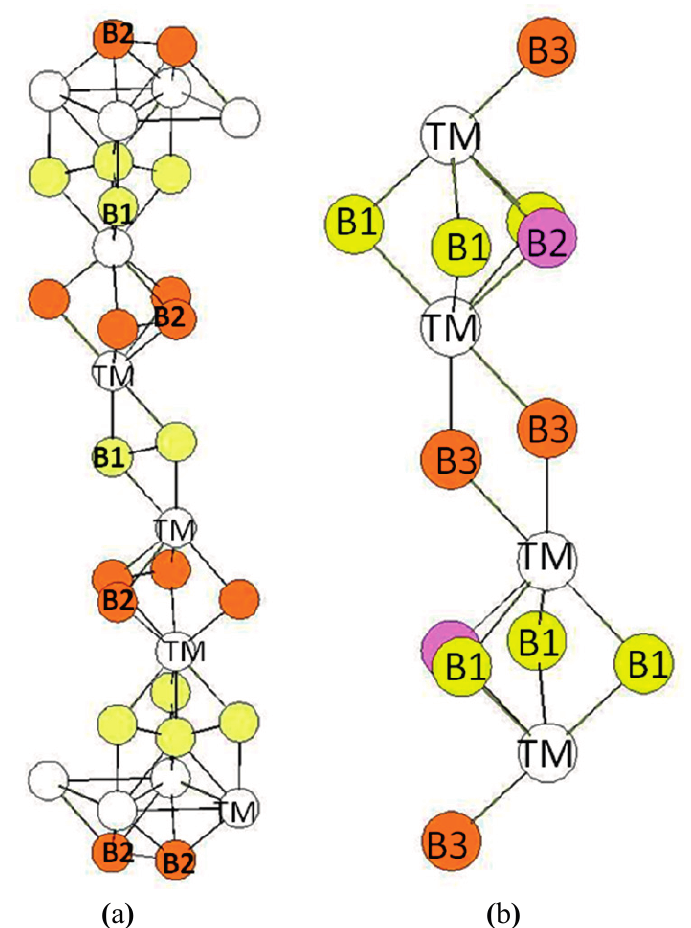
Figure 5. ( a ) hR6 (MoB 2 -type) structure. The Wyckoff positions of B1 and B2 atoms in the R(-)3m group space are 2c (x = y = z = 0.33219) and 2c (x = y = z = 0.18146); ( b ) hP12 (WB 2 -type) structure. The Wyckoff positions of B1, B2, and B3 atoms in the P6 3 /mmc group space are 2b, 2c, and 4f (see Table 1). Table 5. Bond lengths in the hR6-MoB 2 compound. The Wyckoff positions of the B1 and B2 atoms are indicated in Table 1. Atom Env. Number Distance(Å) B1